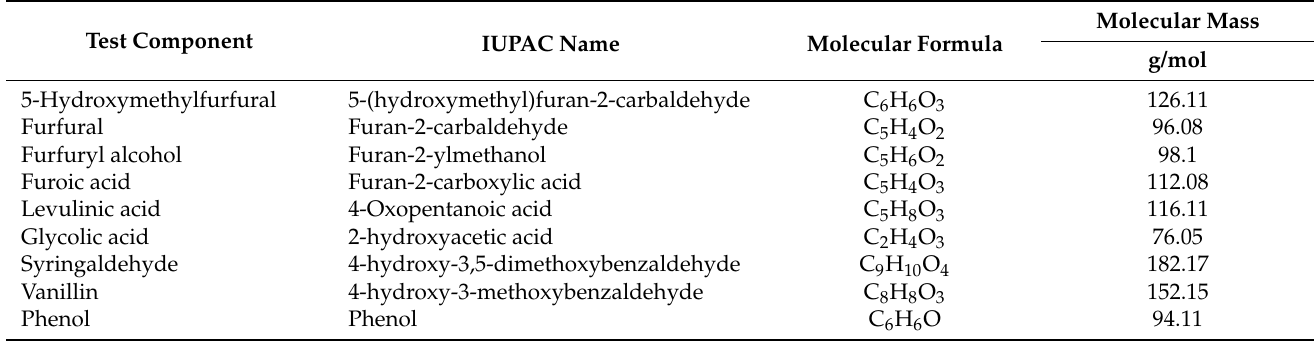
Table 2. Characteristics of the selected components of 5-hydroxymethylfurfural process-wastewater, furfural metabolites, and the phenols utilized in this